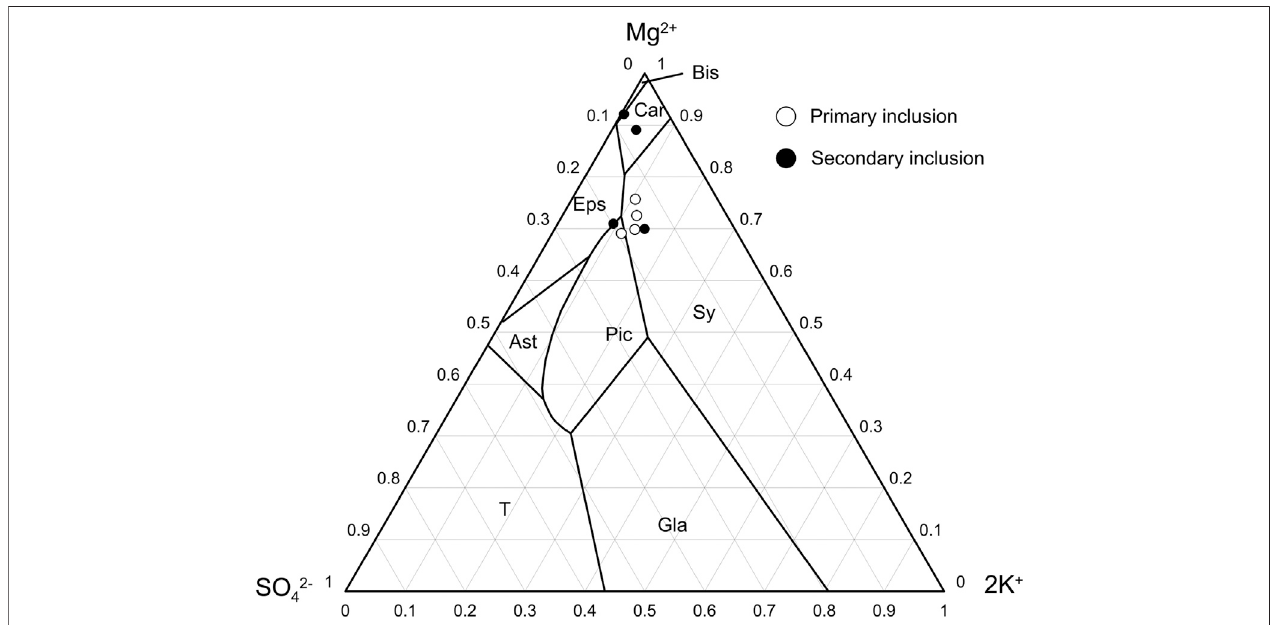
FIGURE 8 | Projection points of fl uid composition of halite inclusions in metastable phase diagram of K – Na – Mg – SO 4 – Cl system (after Meng et al., 2013). Car — KCl ·